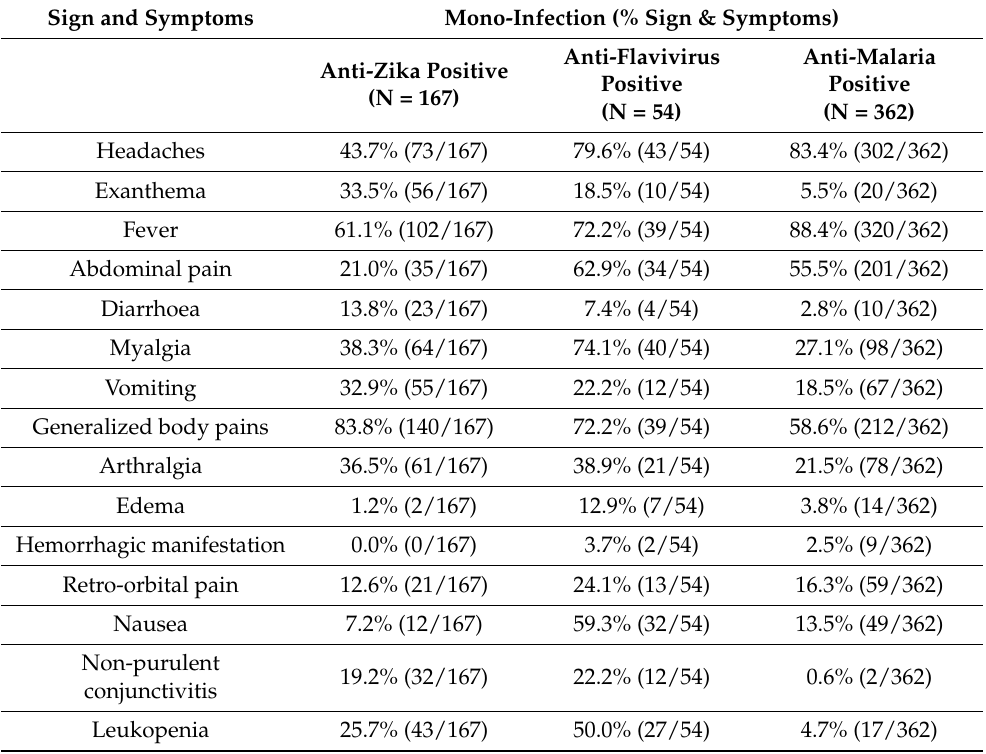
Table 1. Signs and symptoms presented by ZIKV, FLAVI, and malaria monoinfected patients. Sign and